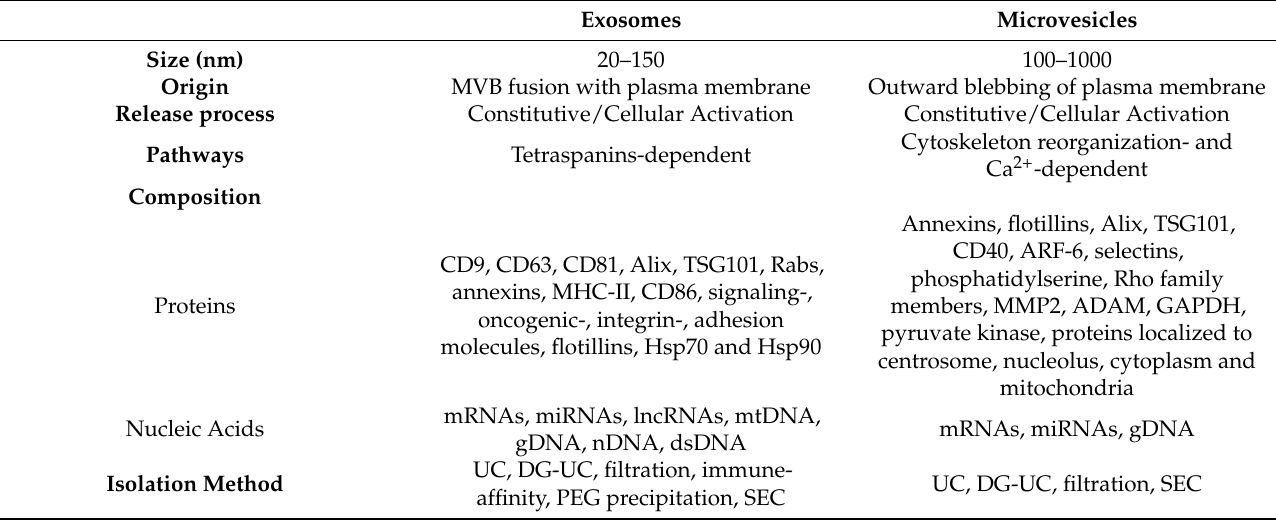
Table 1. Overview of EVs: their size, origin, composition and isolation techniques. Exosomes